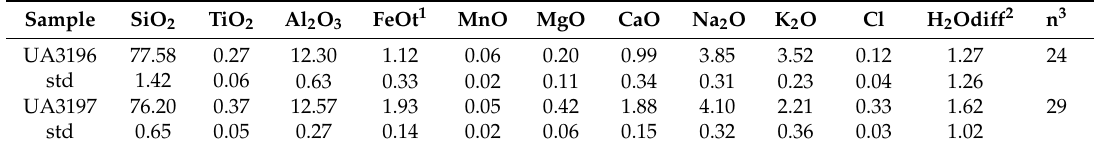
Table 2. Averages and standard deviations (std) of major-element glass geochemistry of tephra samples.